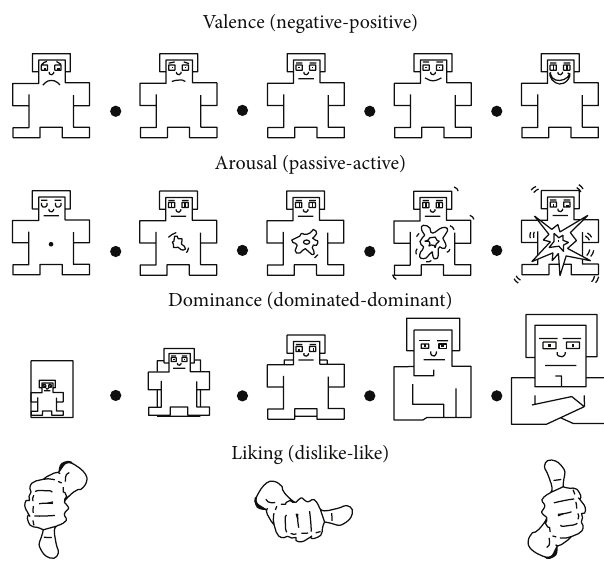
Figure 7: Self-assessment manikin for emotion states